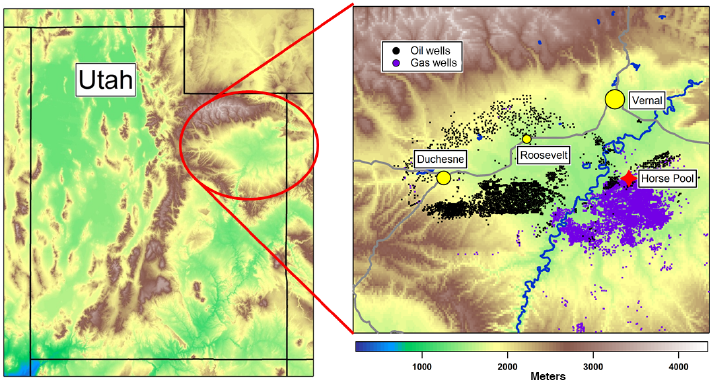
Figure 1. Map of the Uintah Basin in Utah, showing the Horsepool measurement site, active oil and gas wells, and the major population centers. The background is colored by elevation as shown by the color